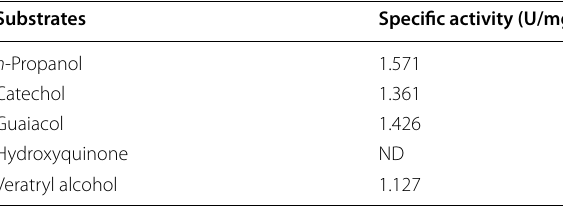
ND not detected